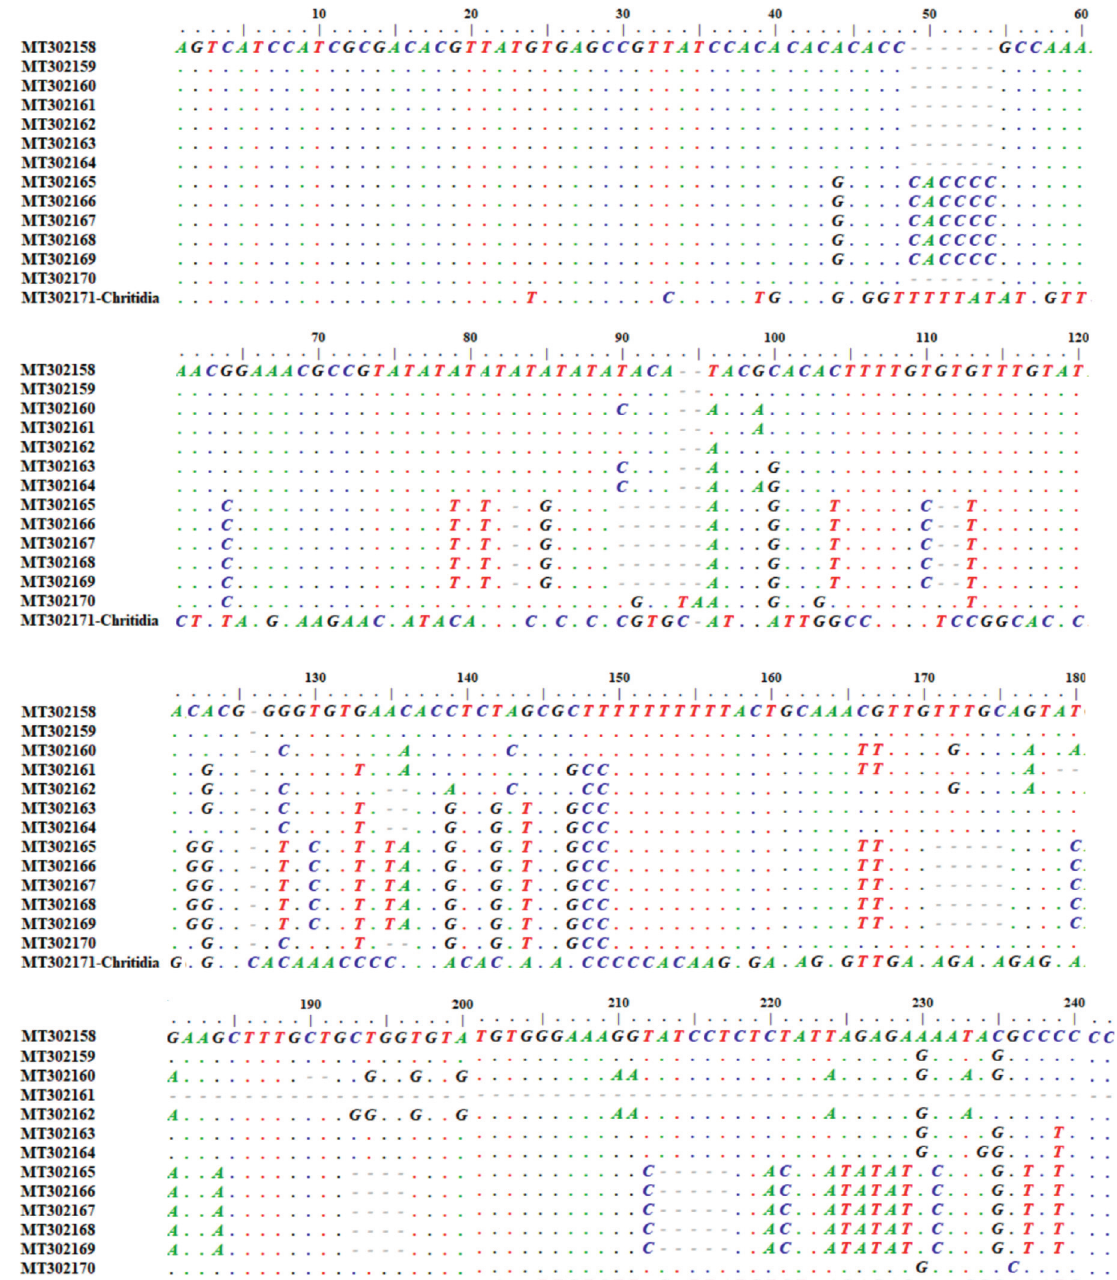
Figure 4: Alignments of ITS1 sequences of Leishmania from asymptomatic and symptomatic VL